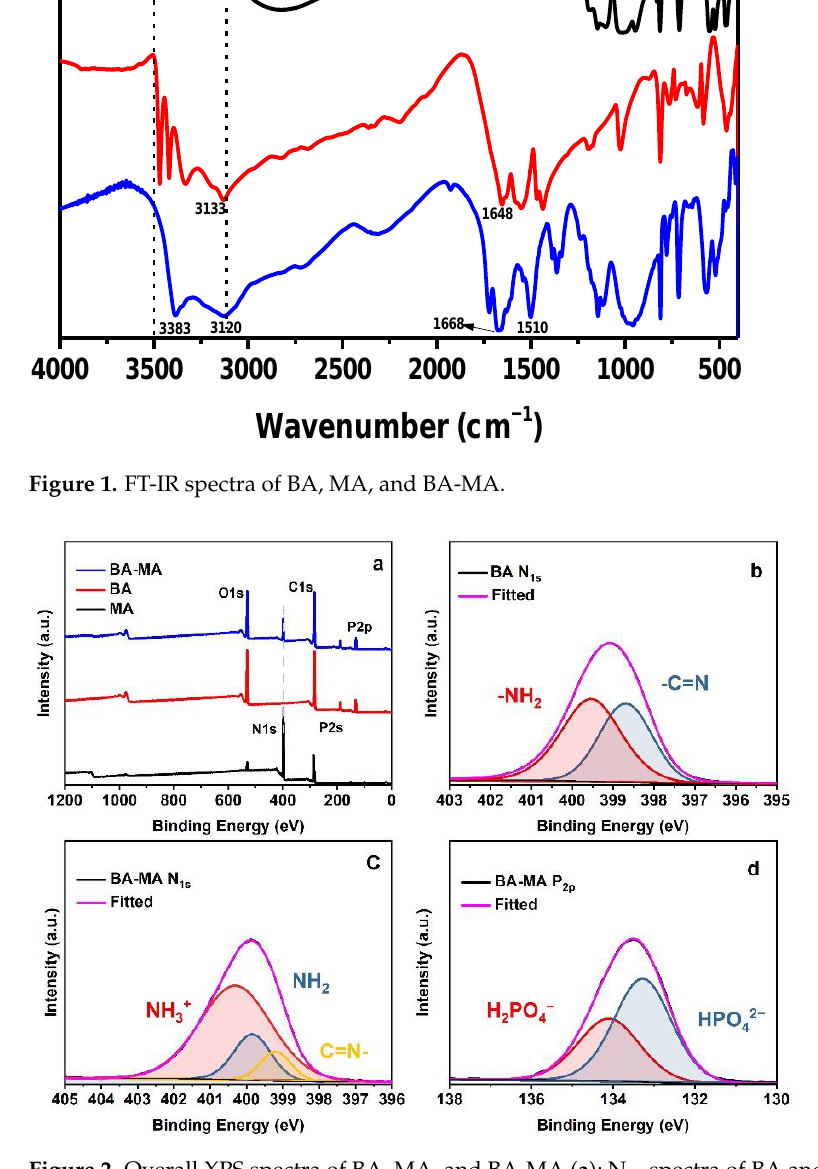
Figure 2. Overall XPS spectra of BA, MA, and BA-MA ( a ); N 1s spectra of BA and its peak fitting ( b ); N 1s spectra of BA-MA and its peak fitting ( c ); P 2p spectra of BA-MA and its peak fitting ( d ).